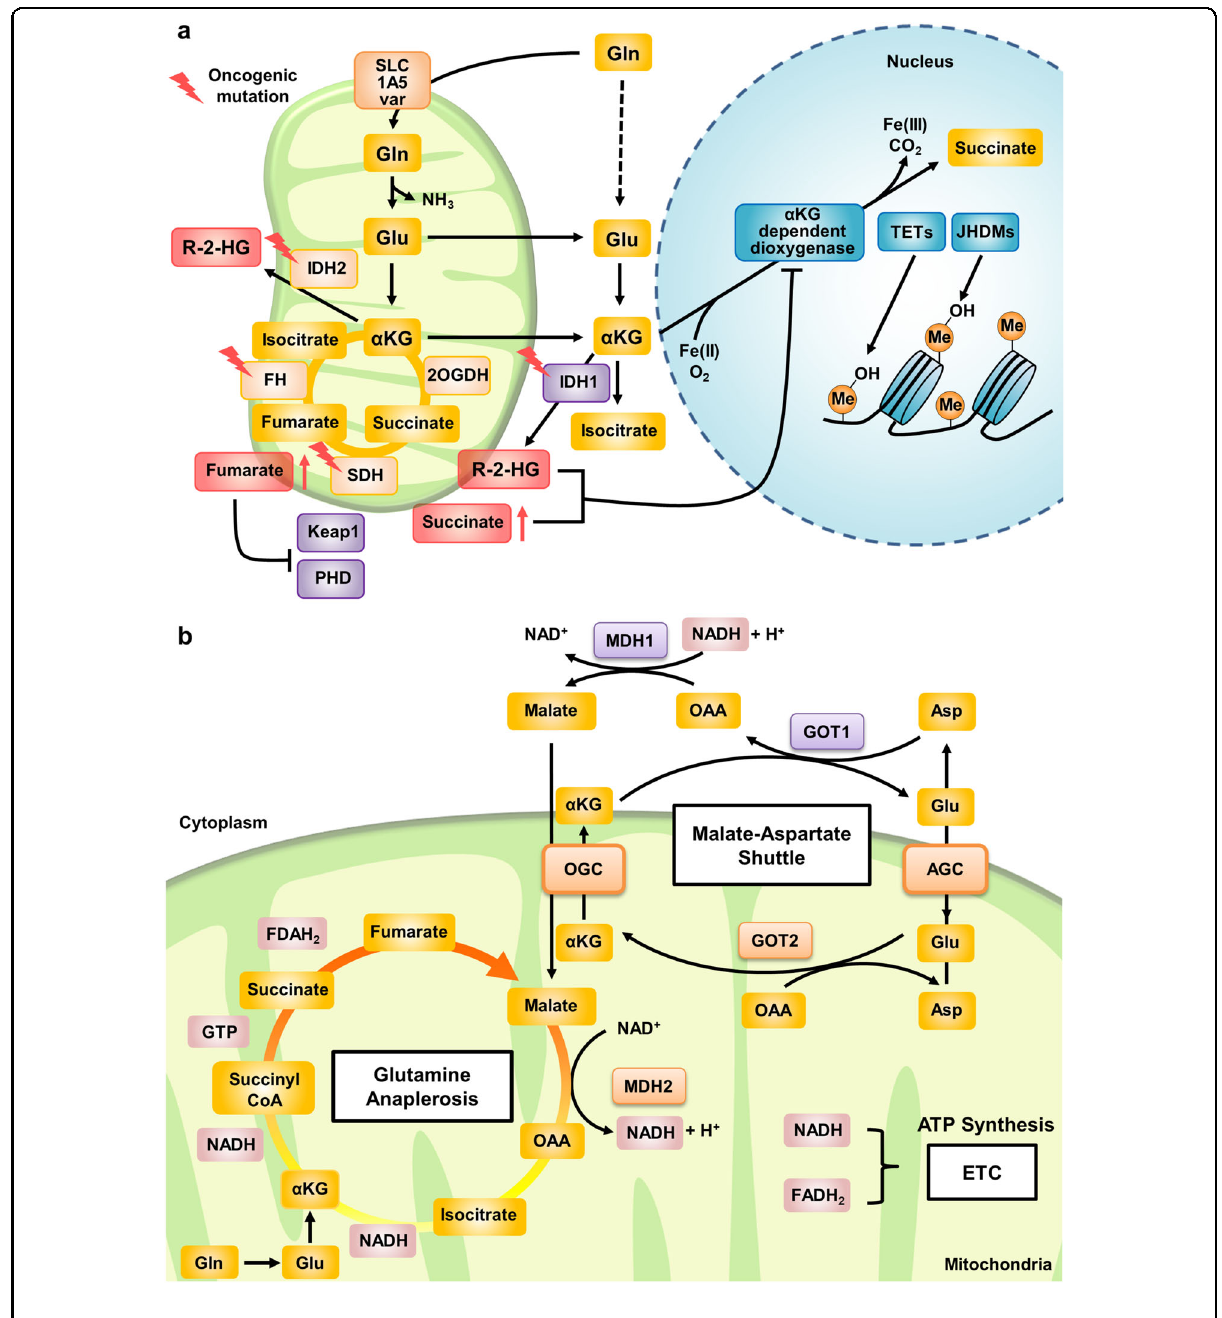
Fig. 5 (See legend on next